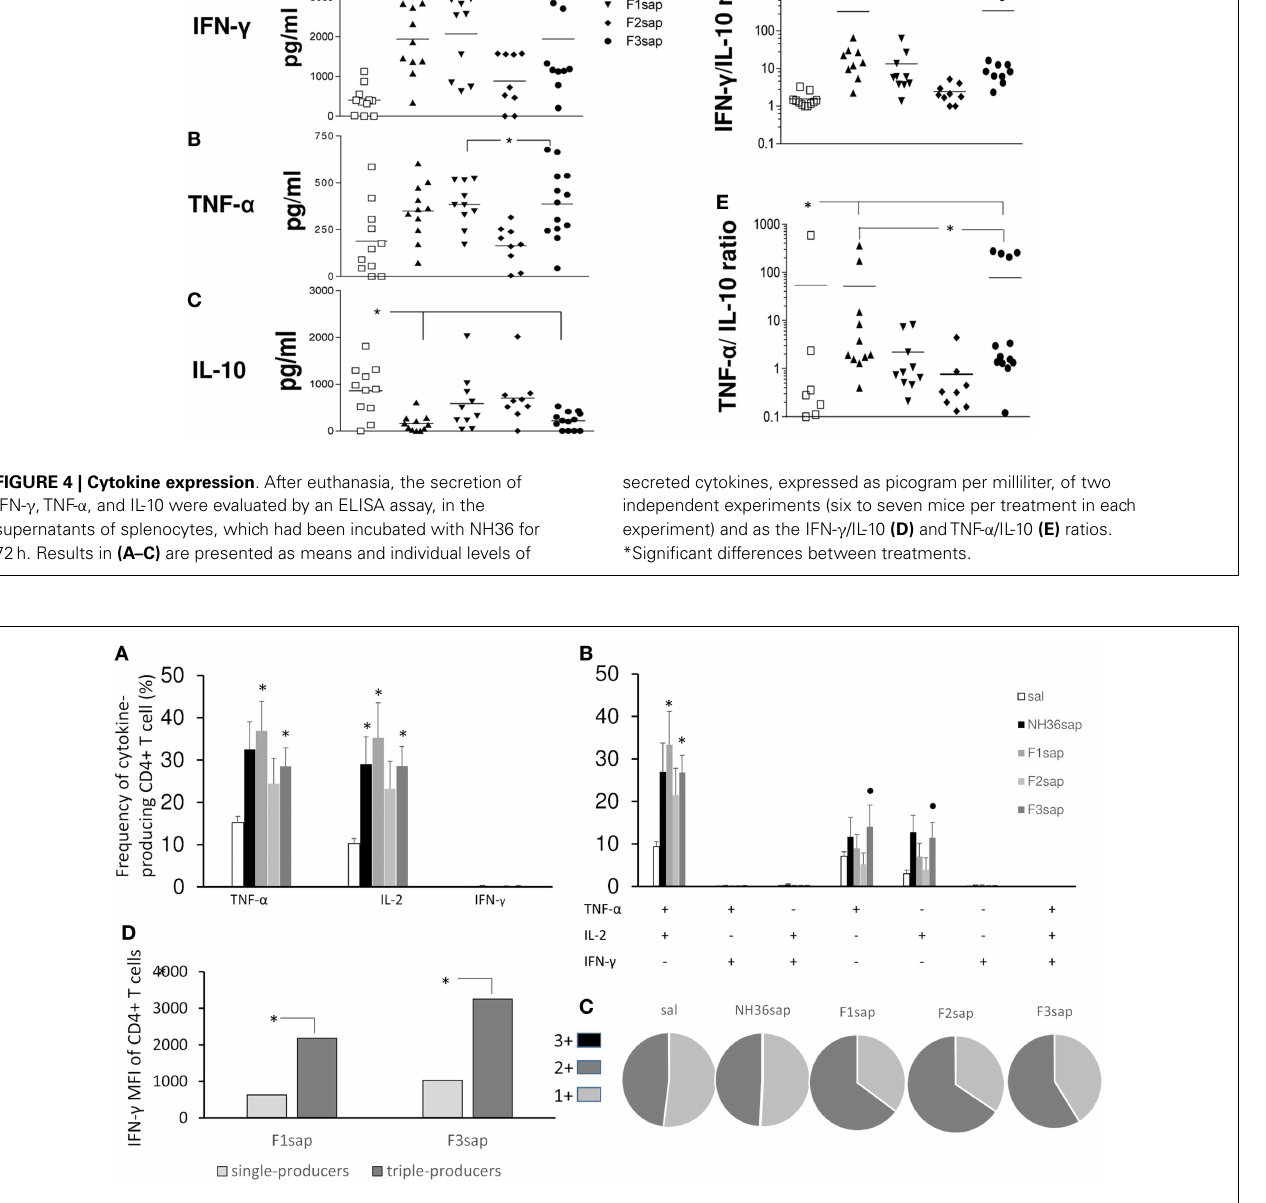
FIGURE 5 | Multifunctional analysis discloses the magnitude and quality of the CD4 + T cell response . NH36-specific cytokine production from CD4 + T cells of spleens of immunotherapy treated and control mice 9weeks after infection (A–C) . Multiparameter flow cytometry was used to determine (A) the total frequency of IFN- γ -, IL-2-, orTNF- α -producing CD4 + T cells, (B) the frequency of cells expressing each of the seven possible combinations of IFN- γ , IL-2, andTNF- α , (C) the magnitude of the IFN- γ